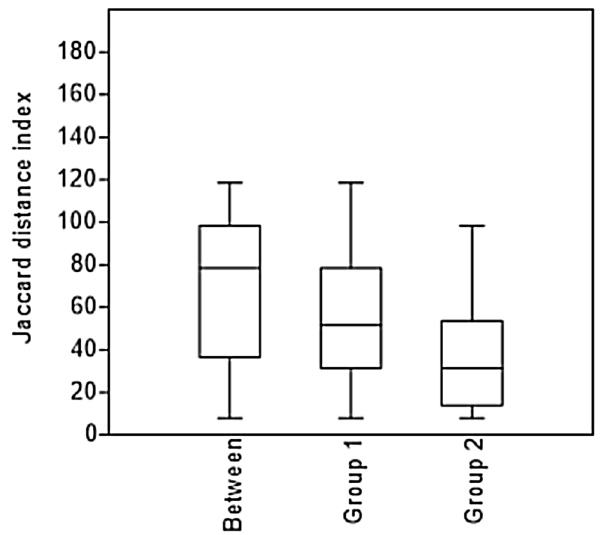
Figure 1. One-way ANOSIM box plot based on the two datasets represented by the occurrences of RLL species between NPAs and PAs (Group 1 is represented by PAs, and Group 2 is represented by